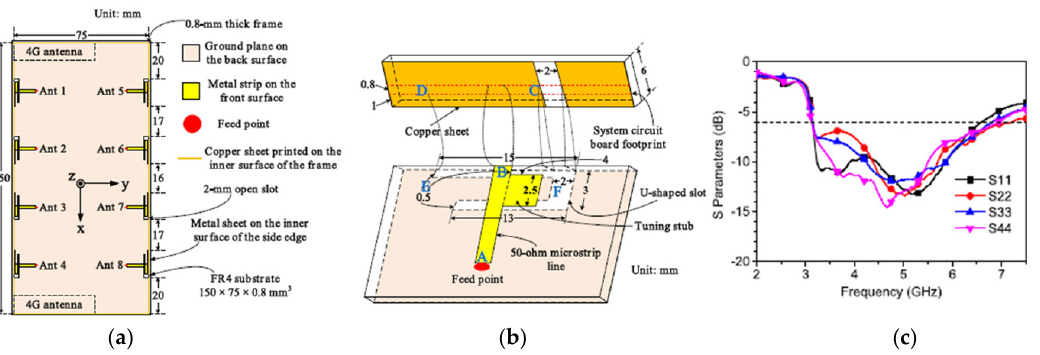
Figure 11. Eight − element MIMO antenna: [61] ( a ) configuration of the whole antenna, ( b ) detailed structure of slot antenna, and ( c ) measured reflection coefficient.